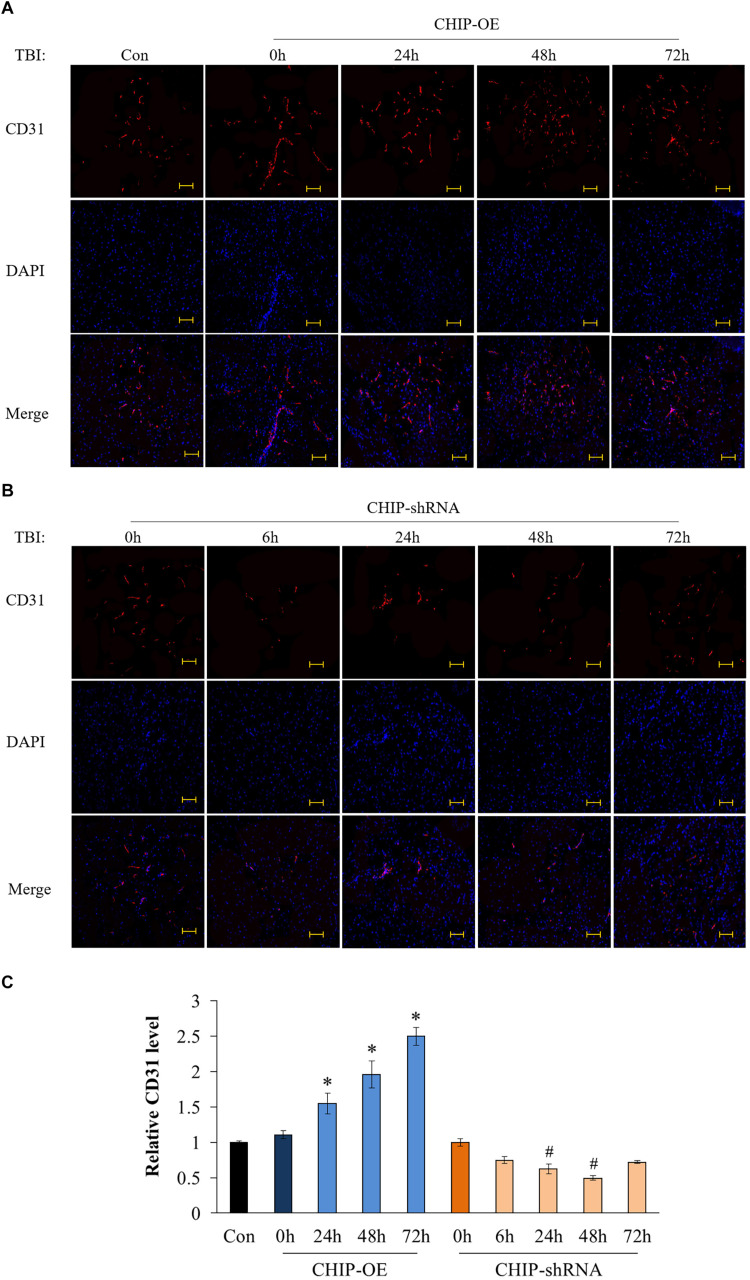
C terminus of Hsc70-interacting protein (CHIP) overexpression increased micrangium density in pericontusional areas after in vivo traumatic brain injury. (A) Immunofluorescence results of CD31 in pericontusional cortex after 0, 24, 48, and 72 h of CCI in CHIP-OE group. (B) Immunofluorescence results of CD31 in pericontusional cortex after 0, 6, 24, 48, and 72 h of CCI in CHIP-shRNA group. (C) Relative expression levels of CD31. CHIP-OE 24, 48, and 72 h vs. CHIP-OE-0h, ∗p < 0.05; CHIP-shRNA 6, 24, 48, and 72 h vs. CHIP-shRNA-0h, #p < 0.05. Scale bars: 50 μm.